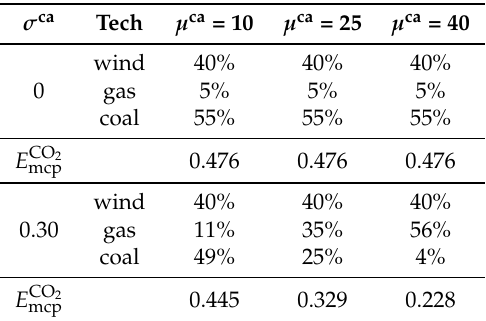
Table 5. Composition of minimum CVaRD systemic portfolios. CO 2 emissions rates of such portfolios are also